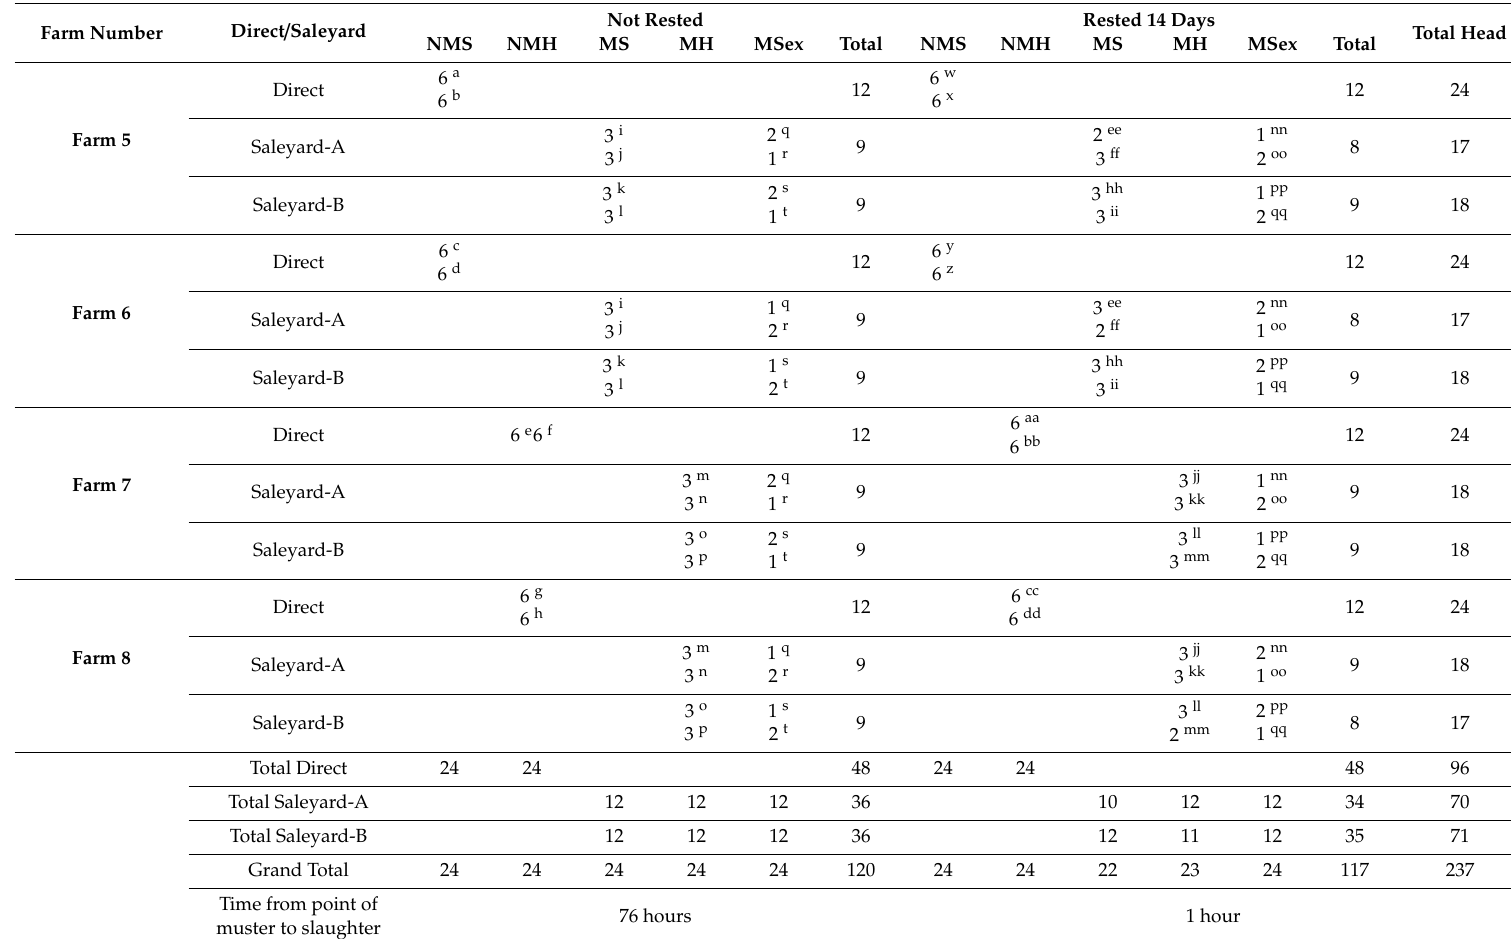
Table 2. Experiment Two. Number of cattle by location, farm, mixing, transport and slaughter interval (Total slaughter count. Excludes three cattle eliminated from the trial). Superscripts “a-t” demonstrate common groups during transport and